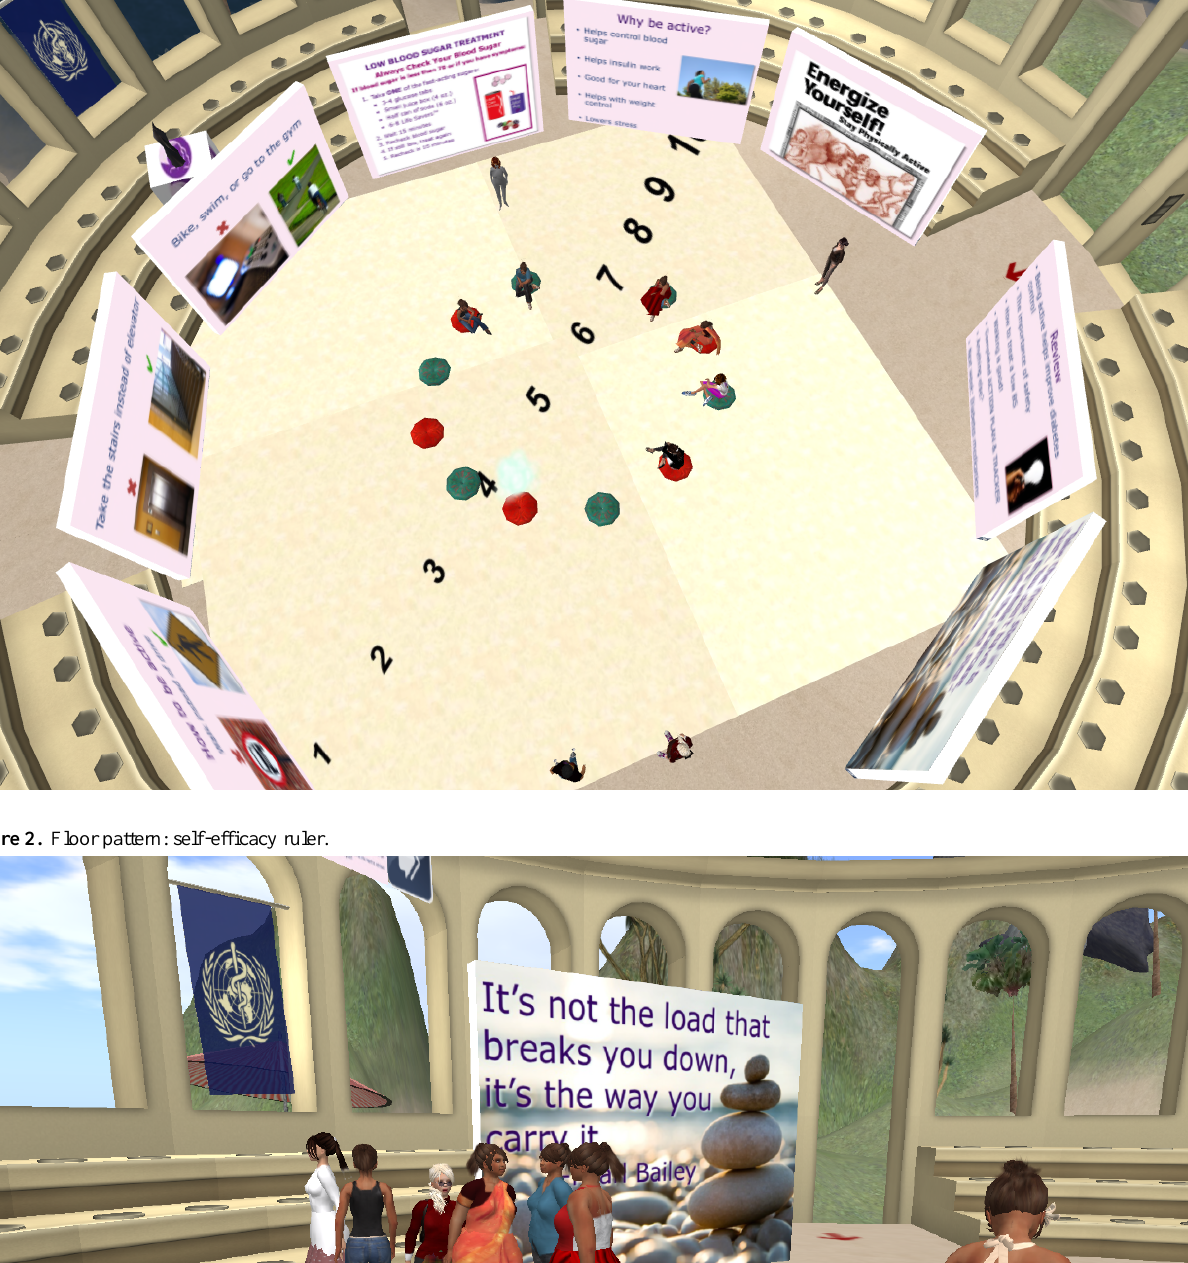
Figure 1. Virtual world forum.